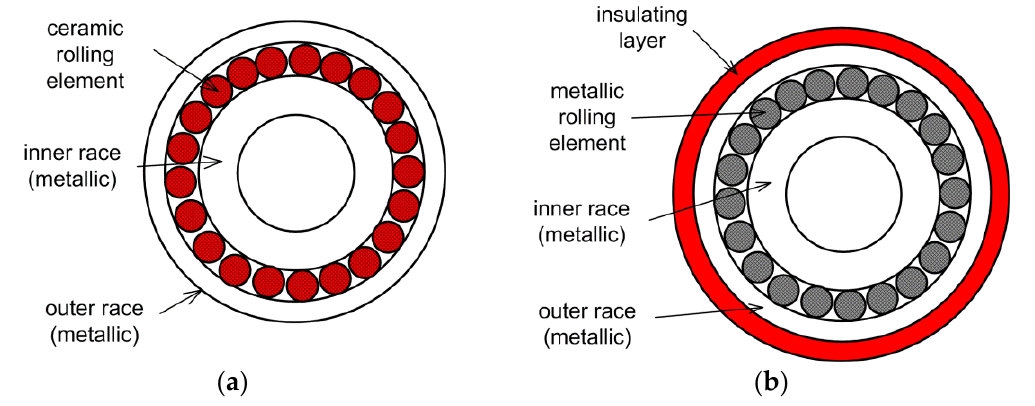
Figure 4. Bearing cross-section: ( a ) hybrid; ( b ) insulated.